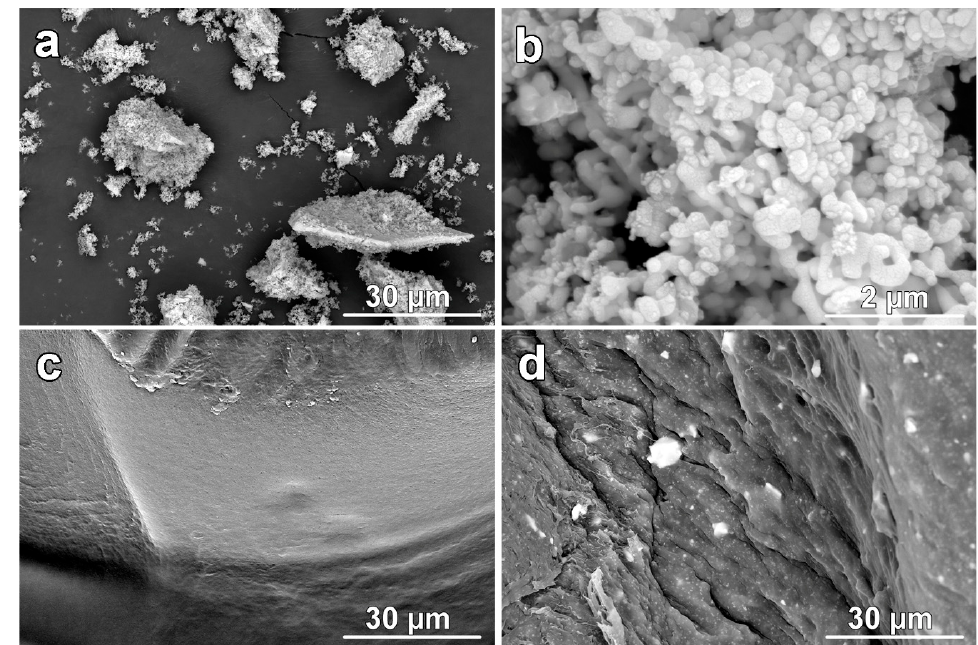
Figure 6. The collection of SEM images: ( a )—Particles of metal oxides observed at lower magnification, ( b )—Microstructure of metal oxides particles observed at higher magnification, ( c )—Internal structure of PET-G sample, ( d )—Internal structure of PET-G sample containing additive.